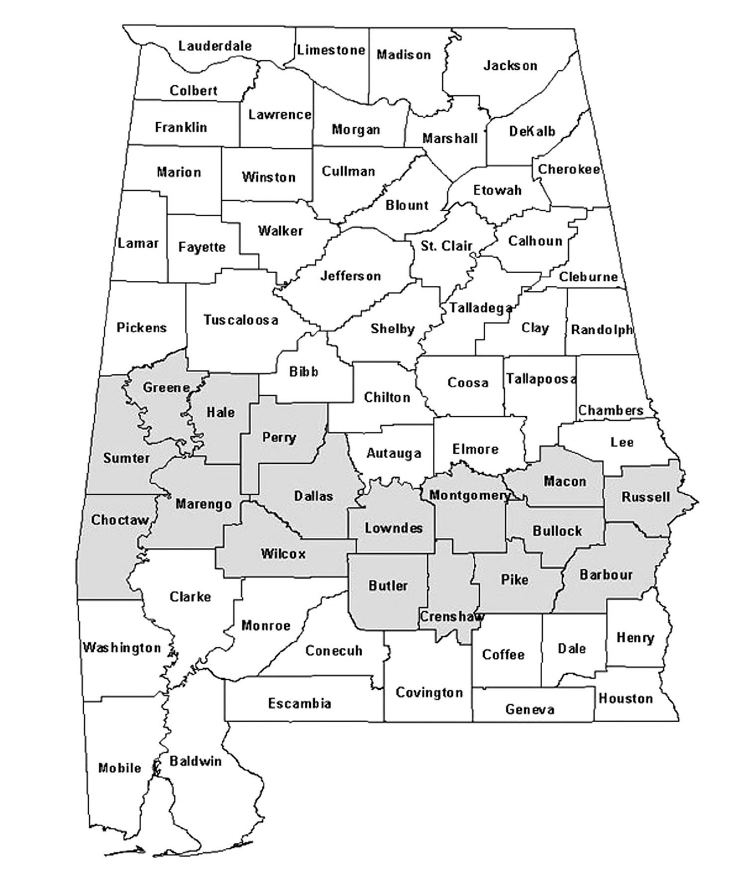
Figure 1. Counties in Alabama’s Black Belt